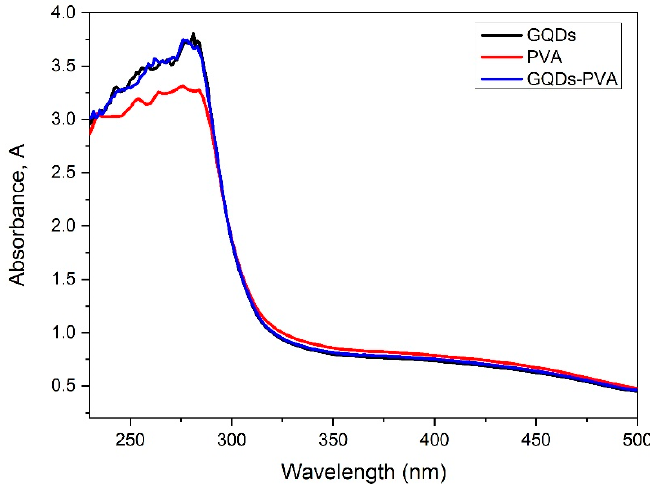
Figure 9. UV-Vis absorption spectra of GQDs, PVA, and GQDs − PVA thin films.